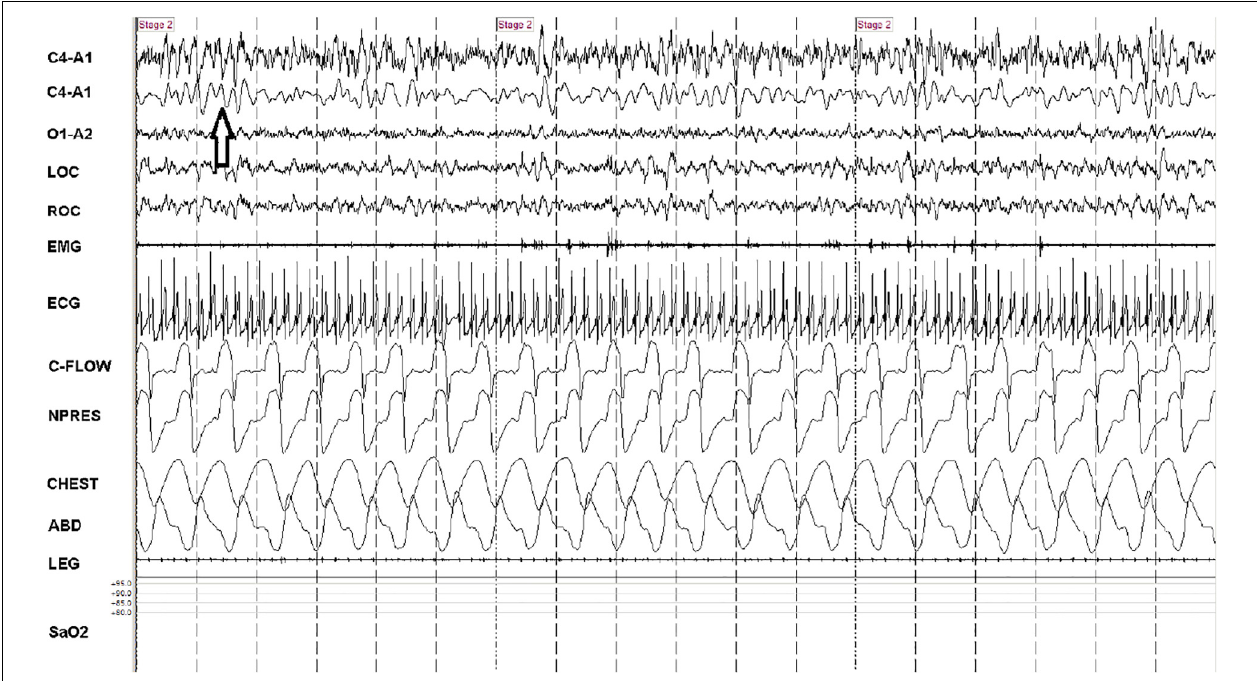
FIGURE 2 | Consolidated/continuous slow oscillation/down states. A 90-s snapshot showing sleep state features of effective NREM, stage N2. Note occurrence of several cycles of the slow oscillation/cortical down states (arrow) within the 5-s vertical time stamps. The second trace (from above) is a duplicate C4-A1 with filters adjusted to remove frequencies > 1 Hz. Note strong respiratory modulation of ECG amplitude, which is a key input signal (the ECG-derived respiration) for cardiopulmonary coupling analysis. At this compression, heart rate variability is not readily identified, but the spectrogram is high frequency coupling. Note stable respiration. C-FLOW: flow from positive airway pressure device. NPRESS: nasal pressure. C4, O1: central and occipital standard EEG sites. A: auricle/mastoid reference. EMG: chin electromyogram. LOC/ROC: left and right outer canthus. LEG: combined right and left tibialis anterior electromyogram. SaO 2 : oxygen saturation via finger probe. ECG: